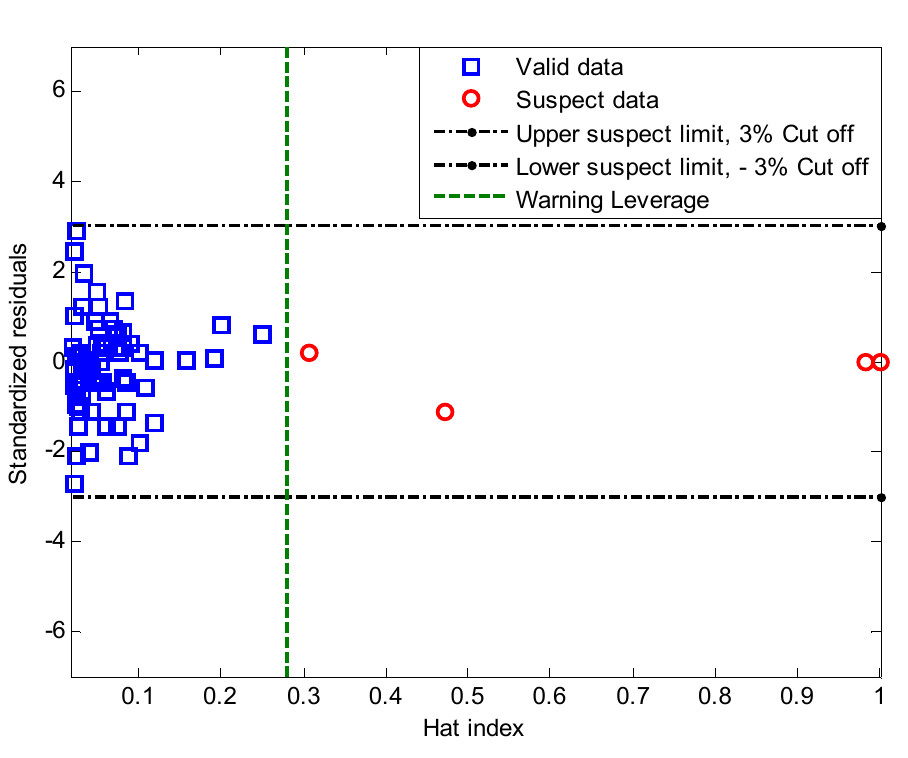
Figure 6. Williams plot for the MLP model.